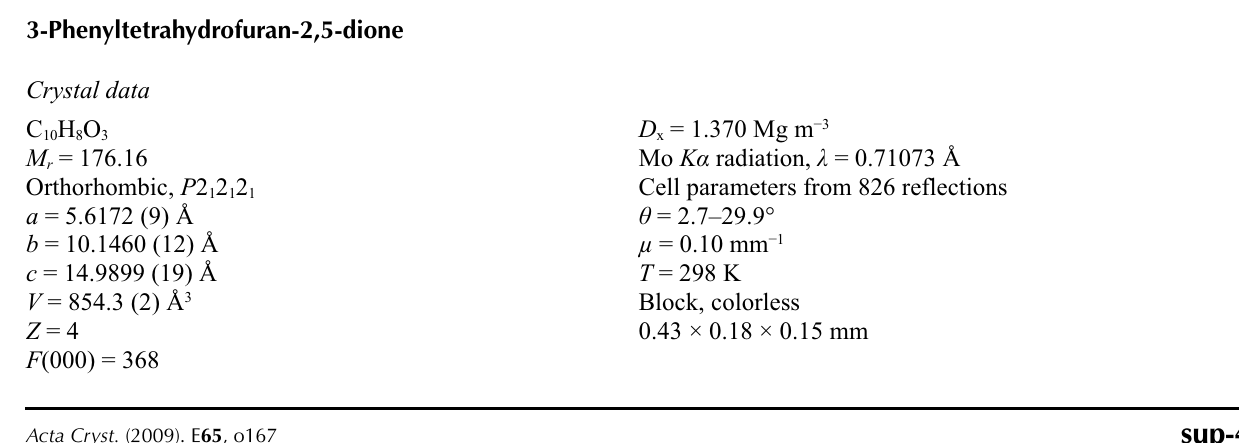
A section of the structure of (II) viewed down the a axis (II = 3,3-dimethyl-4-phenyltetrahydrofuran-2,5-dione). The C— H···O bonds extending along the b axis are shown as dashed